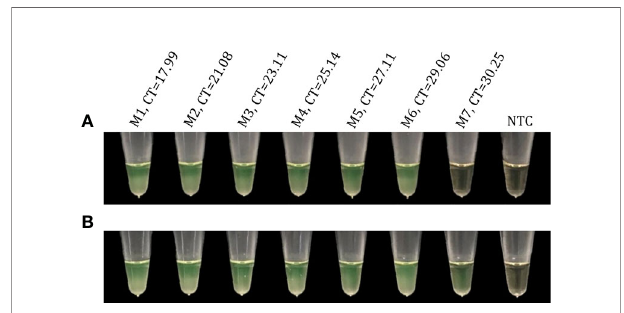
FIGURE 9 | Evaluation of candidate primer sets for SARS-CoV-2 detection using a clinical sample panel with a viral load gradient. Reactions using the candidate primer sets R18-8N3-R34 (A) and R16.2-R34-R2 (B) were considered positive for RT-LAMP products if they had a color change from brown to green. Viral RNA obtained from clinical samples were analyzed in parallel by multiplex RT-LAMP and RT-qPCR assays. M1-M7, clinical samples with different cycle threshold (CT) values obtained by RT-qPCR; NTC, negative non-template control.